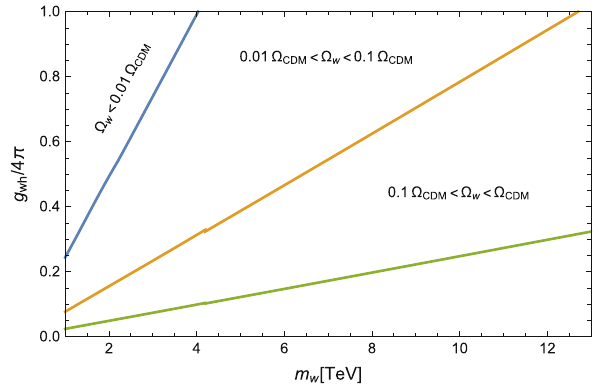
Fig. 2 Regionsinthe ( m w , g w h ) planewheretheHiggsportalcoupling isperturbativeandthecontributionofthermallycreatedheavy w mesons to dark matter is